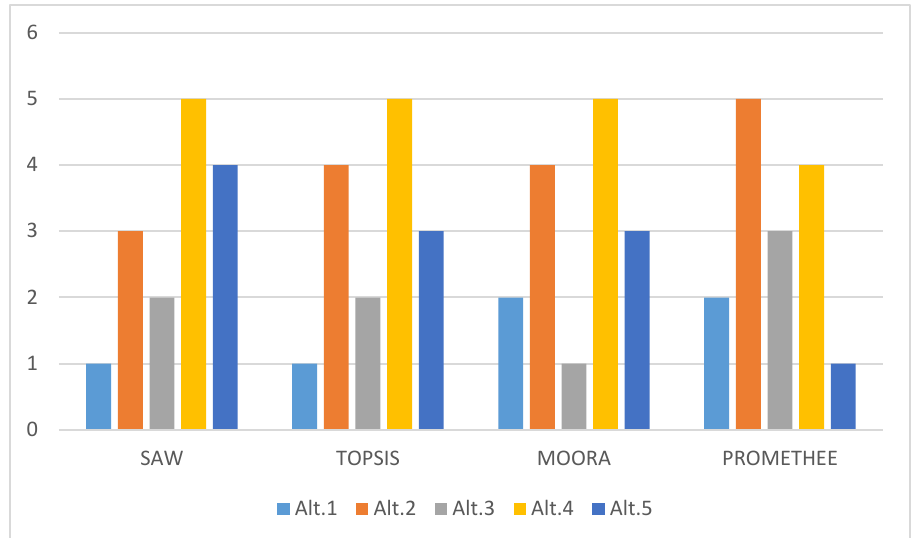
Figure 3. The results obtained using MADM methods. SAW: Simple Additive Weighting; TOPSIS: Technique for Order of Preference by Similarity to Ideal Solution; MOORA: Multi-Objective Optimization by Ratio Analysis; PROMETHEE: Preference Ranking Organization Method for Enrichment Evaluation.